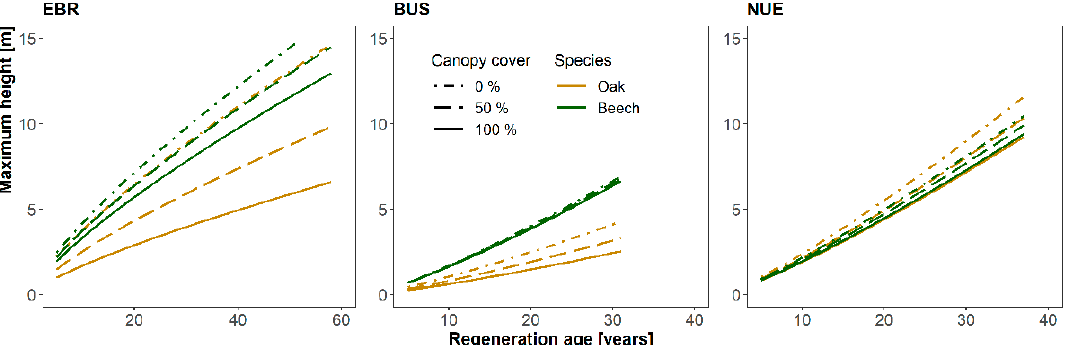
Figure 5. Estimated maximum heights of oak and beech regeneration as a function of regeneration age and canopy cover (Equation (5)); shown are the height trajectories of oak and the most competitive beech species. Note the different scaling of the x -axes.